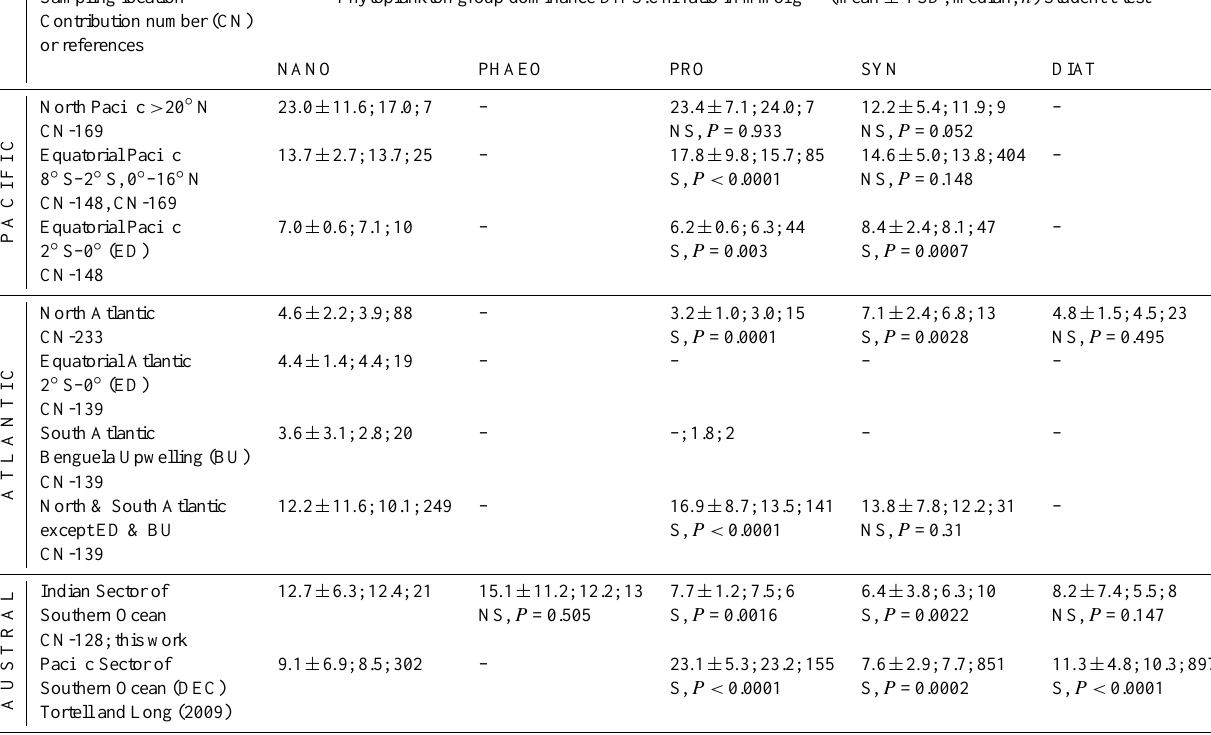
Table 2. Mean DMS:Chl ratios sorted by oceanic regions and by phytoplankton group dominance. Sampling